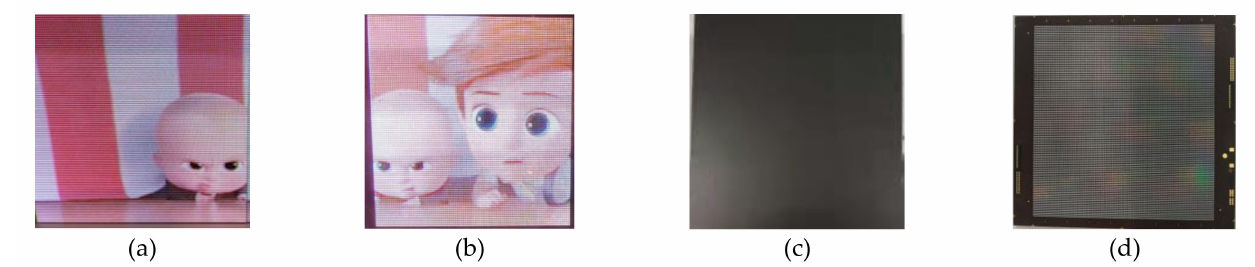
Figure 5. Mini-LED panels with and without coating under ( a , b ) on state and ( c , d ) off